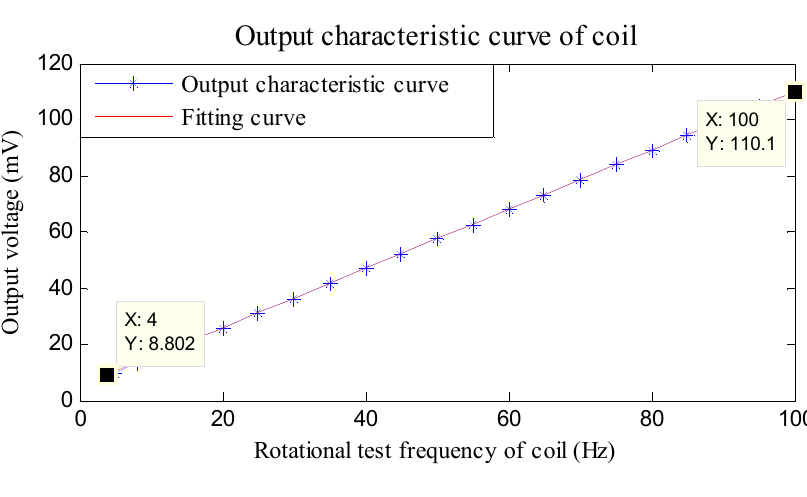
Figure 5. Output characteristic curve of coil.